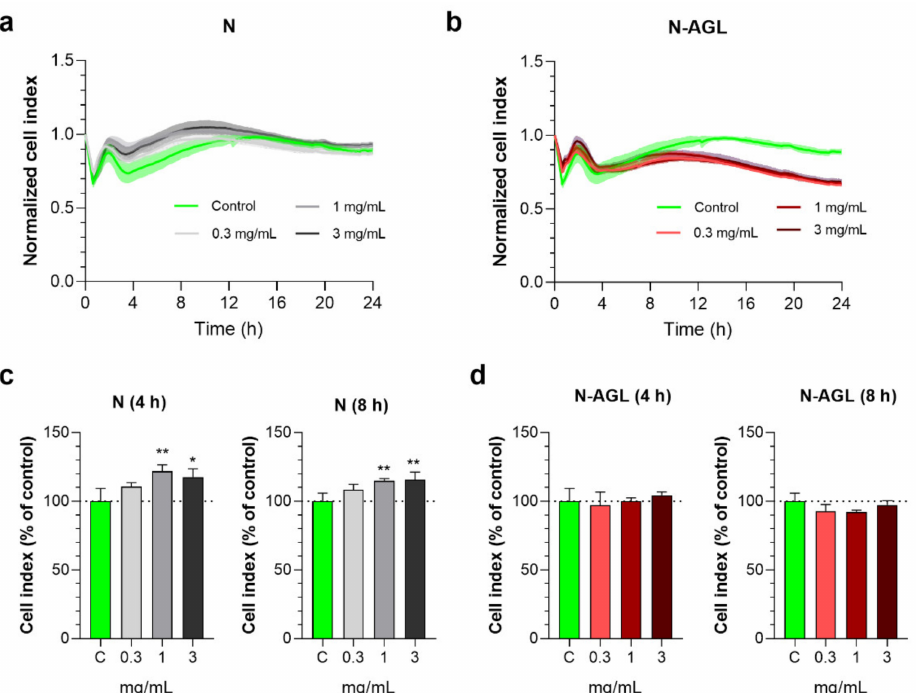
Figure 2. Effect of non-targeted (N) and ascorbic acid-glutathione-leucine-targeted (N-AGL) nanopar- ticles on the impedance of primary rat brain endothelial cells monitored by real-time measurements. Kinetics of brain endothelial cell responses to ( a ) N and ( b ) N-AGL nanoparticle treatments for 24 h. Values presented are means ± SD and are given as cell index. Impedance of brain endothelial cells treated with N ( c ) or N-AGL ( d ) after 4 or 8 h. Values presented are means ± SD and are given as a percentage of culture medium-treated control. Statistical analysis: one-way ANOVA followed by Dunnett’s post-test; * p < 0.05, ** p < 0.01, compared to the control group; n =